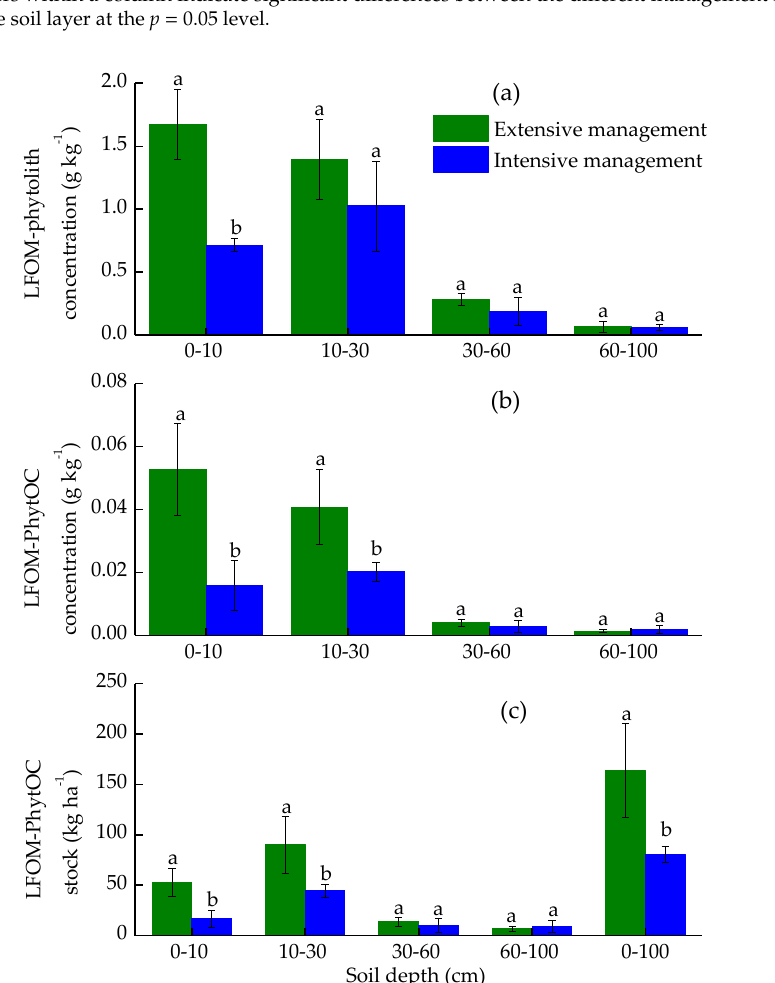
Figure 3. Light fraction organic matter ( a ) phytolith concentration, ( b ) PhytOC concentration and ( c ) PhytOC storage (mean ± SD, n = 3) of di ff erent soil layers from P. pubescens stands with di ff erent a column indicate significant di ff erences between the di ff erent management intensities within the same soil layer at the p = 0.05